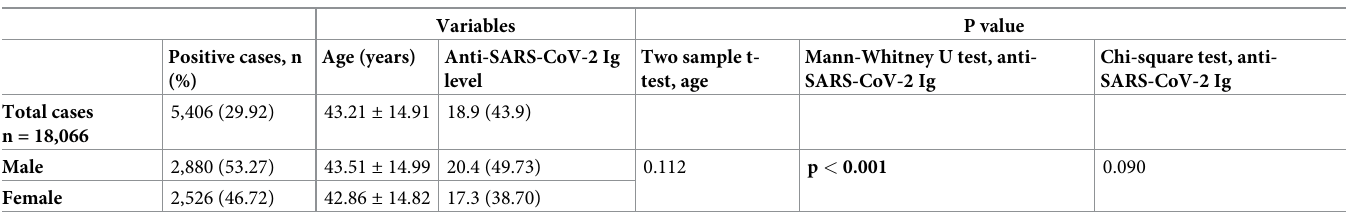
Table 1. The proportion of positive cases and the effect of age and gender.